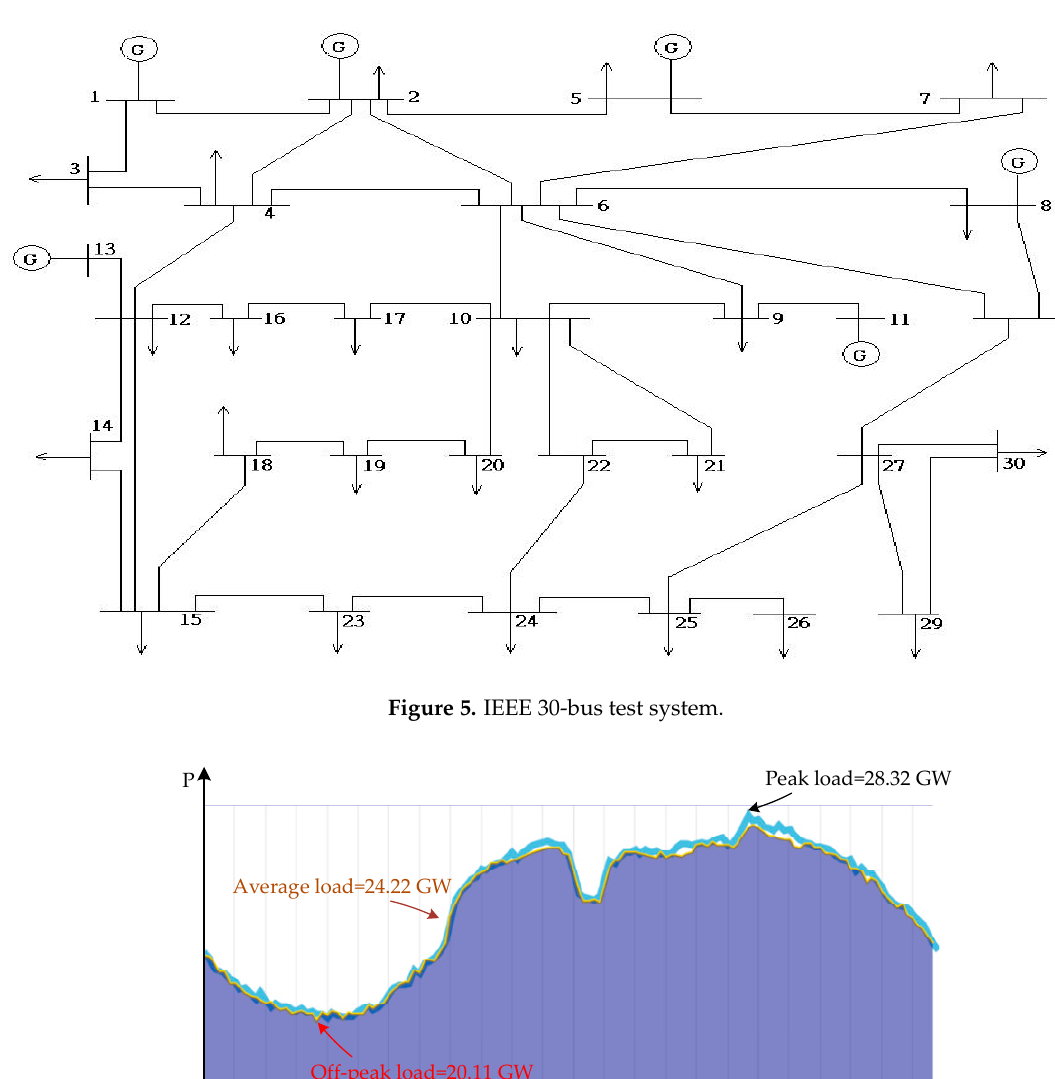
Figure 4. IEEE 14-bus test system.